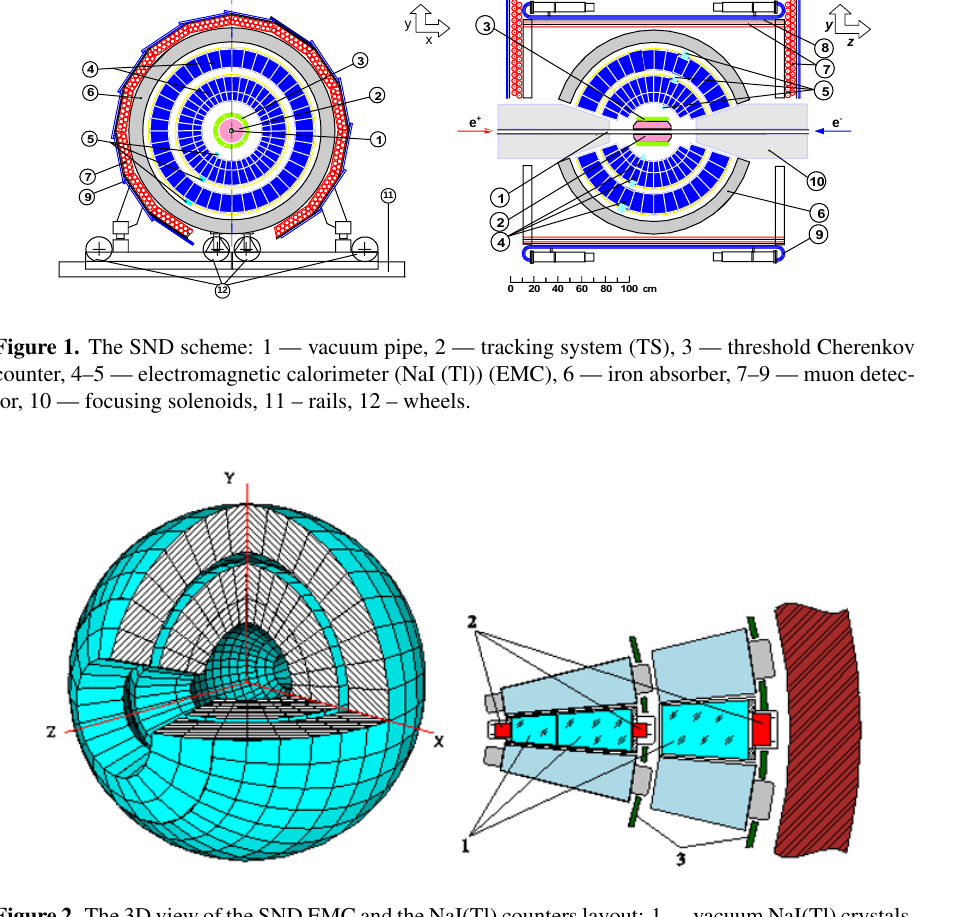
Figure 2. The 3D view of the SND EMC and the NaI(Tl) counters layout: 1 — vacuum NaI(Tl) crystals, 2 — vacuum phototriodes, 3 — aluminum supporting